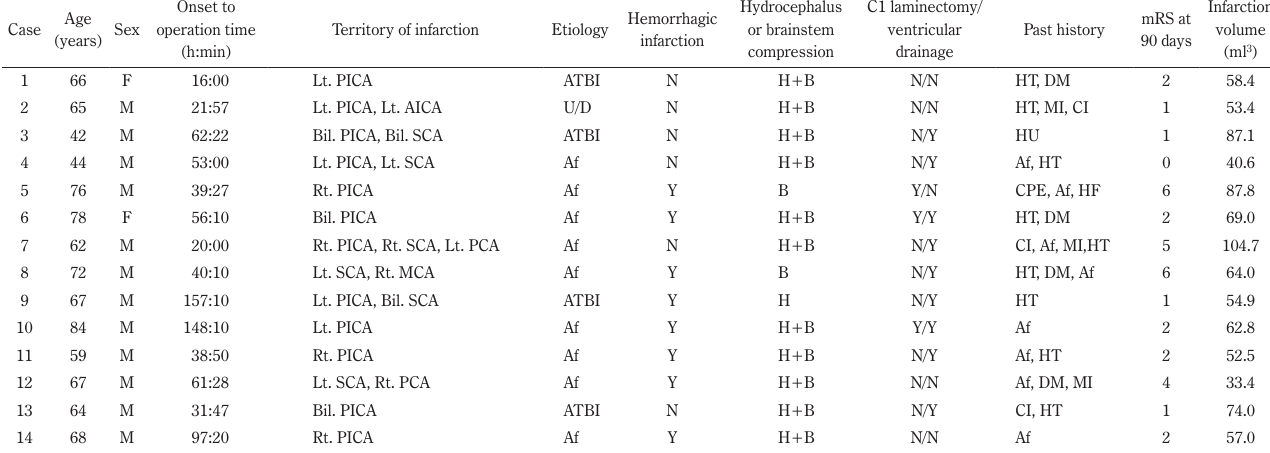
Table 1 Characteristics of 14 patients who underwent decompressive suboccipital craniectomy for cerebellar